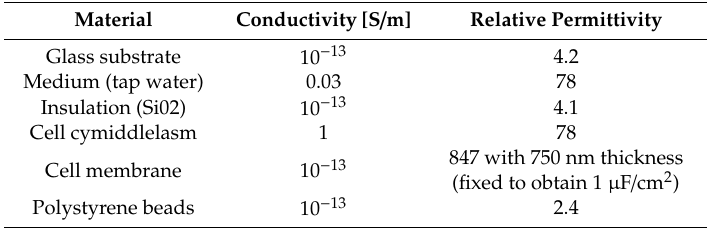
Table 3. Electrical parameters used for Finite Element Method (FEM)